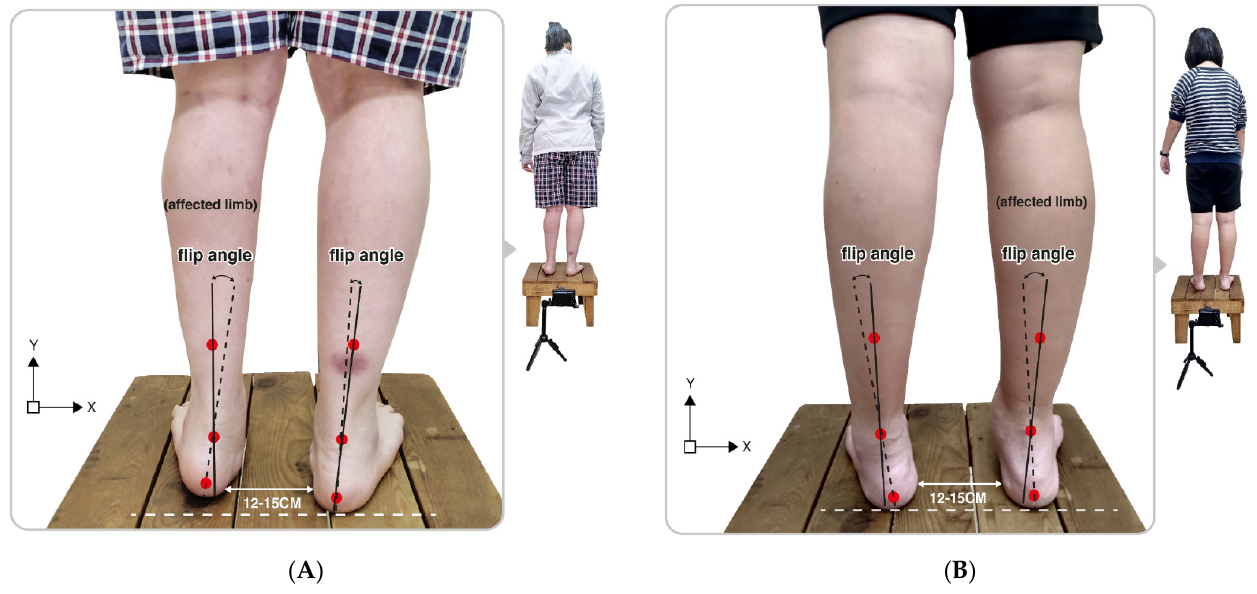
Figure 1. Illustration of the upright posture of the representative participant in ( A ) the left hemiplegic CP and ( B ) the right hemiplegic CP group. Flip angle (static rearfoot angle) was calculated based on the intersection of two straight lines produced from the three positioning markers on the lower legs.